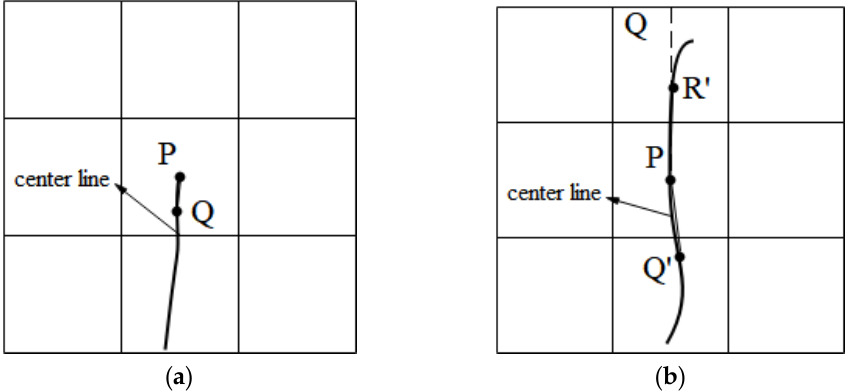
Figure 12. Tangent line at the center line. Where: ( a ) tangent line at end point. ( b ) tangent line at the center point on the line.